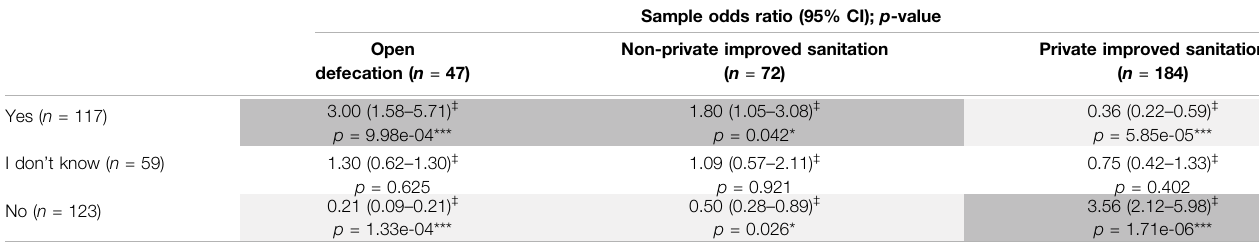
TABLE 6 | Former subscriber responses to “ Would you want to join the EkoLakay service again? ” , by household sanitation status at time of interview ( n (cid:1) 299). Sample odds ratio (95% CI); p -value